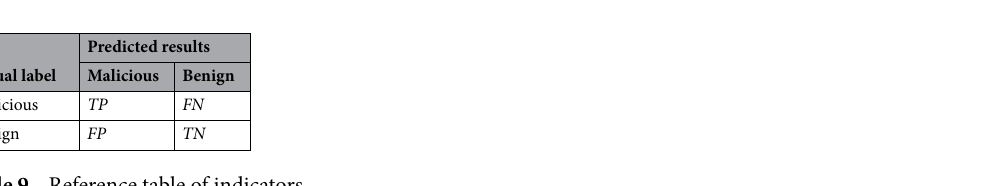
Table 9. Reference table of